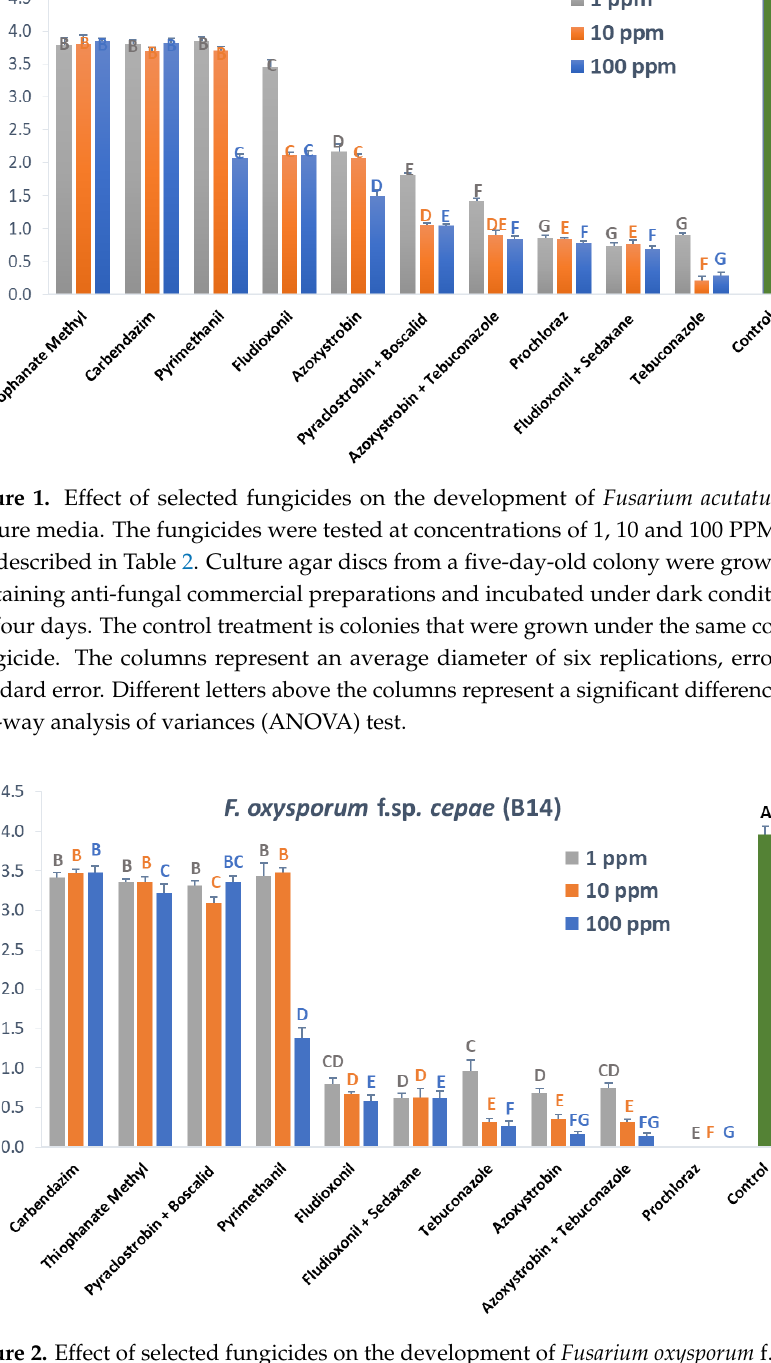
Figure 3. Photograph of the plat e assay for assessing the fungicides’ effectiveness against the on- ion basal rot disease causal agents. The experiment was conducted as described in Figure 1.